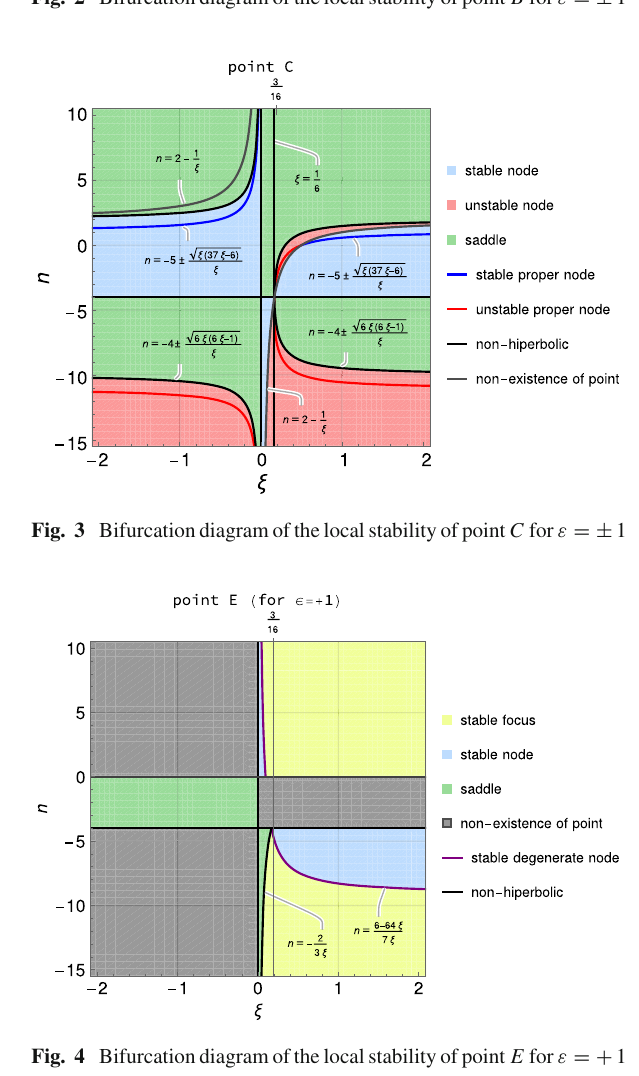
Fig. 1 Bifurcation diagram of the local stability of point A for ε = ± 1 Fig. 2 Bifurcation diagram of the local stabilityof point B for ε = ± 1